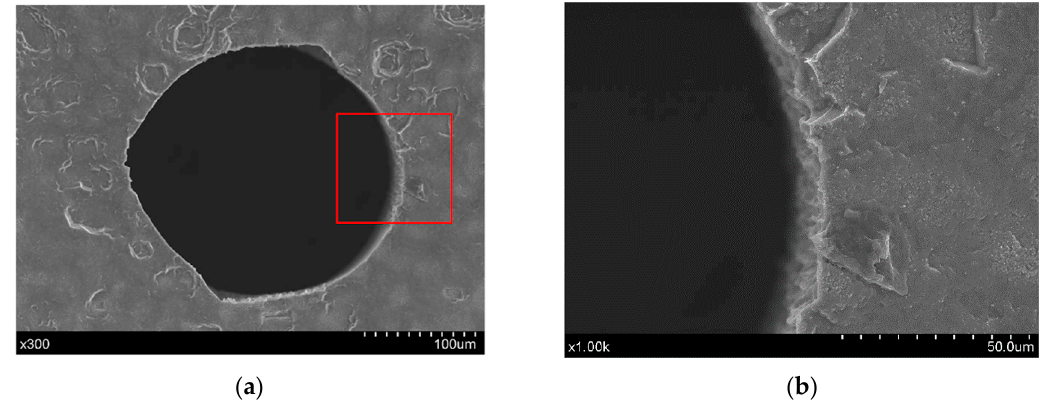
( b ) Figure 12. Exit details of the chemical-assisted micro-trepanning results, where ( a ) is an overall view, while ( b ) shows the details within the red square. The processing parameters include: P = 25.5 W, f = 0.8 MHz, v = 300 mm/s, n = 15, m = 120, and a NaOH solution with a concentration of one mol/L was used in chemical-assisted laser processing. However, in some parts of the hole sidewall, a quite coarse surface can also be noticed, as shown in Figure 13, which appears to be caused by the mechanical effect of the laser-induced plasma and the subsequent cavitation bubbles. Within laser pulse duration, dense free electrons can be produced via multi-photon ionization and impact ionization, leading to the formation of a plasma zone [40], which is of high temperature and high pressure, and exhibits an obvious shielding effect through absorbing the incident laser energy and a strong expelling effect via fast expanding in liquid media [32,38,39]. After a laser pulse, plasma decays rapidly and results in bubble generation in solution [40],